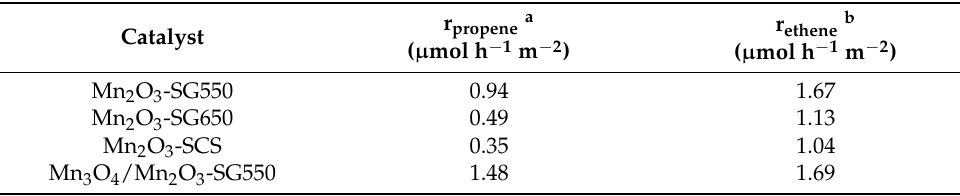
Table 3. Propene and ethene specific reaction rates over the prepared catalysts.